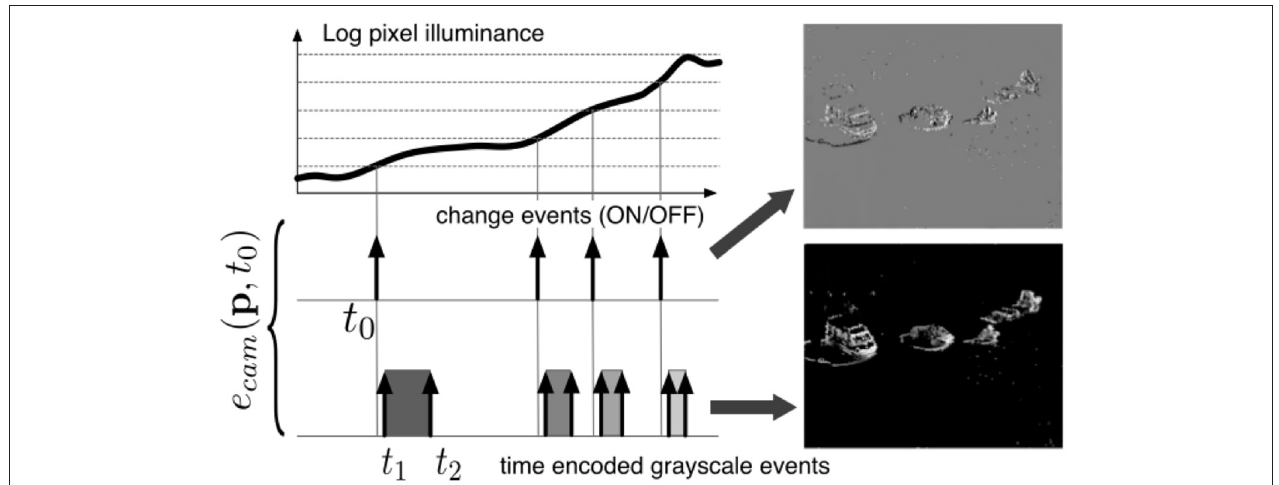
FIGURE 1 | Working principle of the event-based camera and two types of events. (1) Change event of type ON is generated at t 0 as voltage generated by incoming light crosses a voltage threshold. (2) Time t 2 − t 1 to receive a certain amount of light is converted into an absolute gray-level value, emitted at t 2 used for ground truth in the